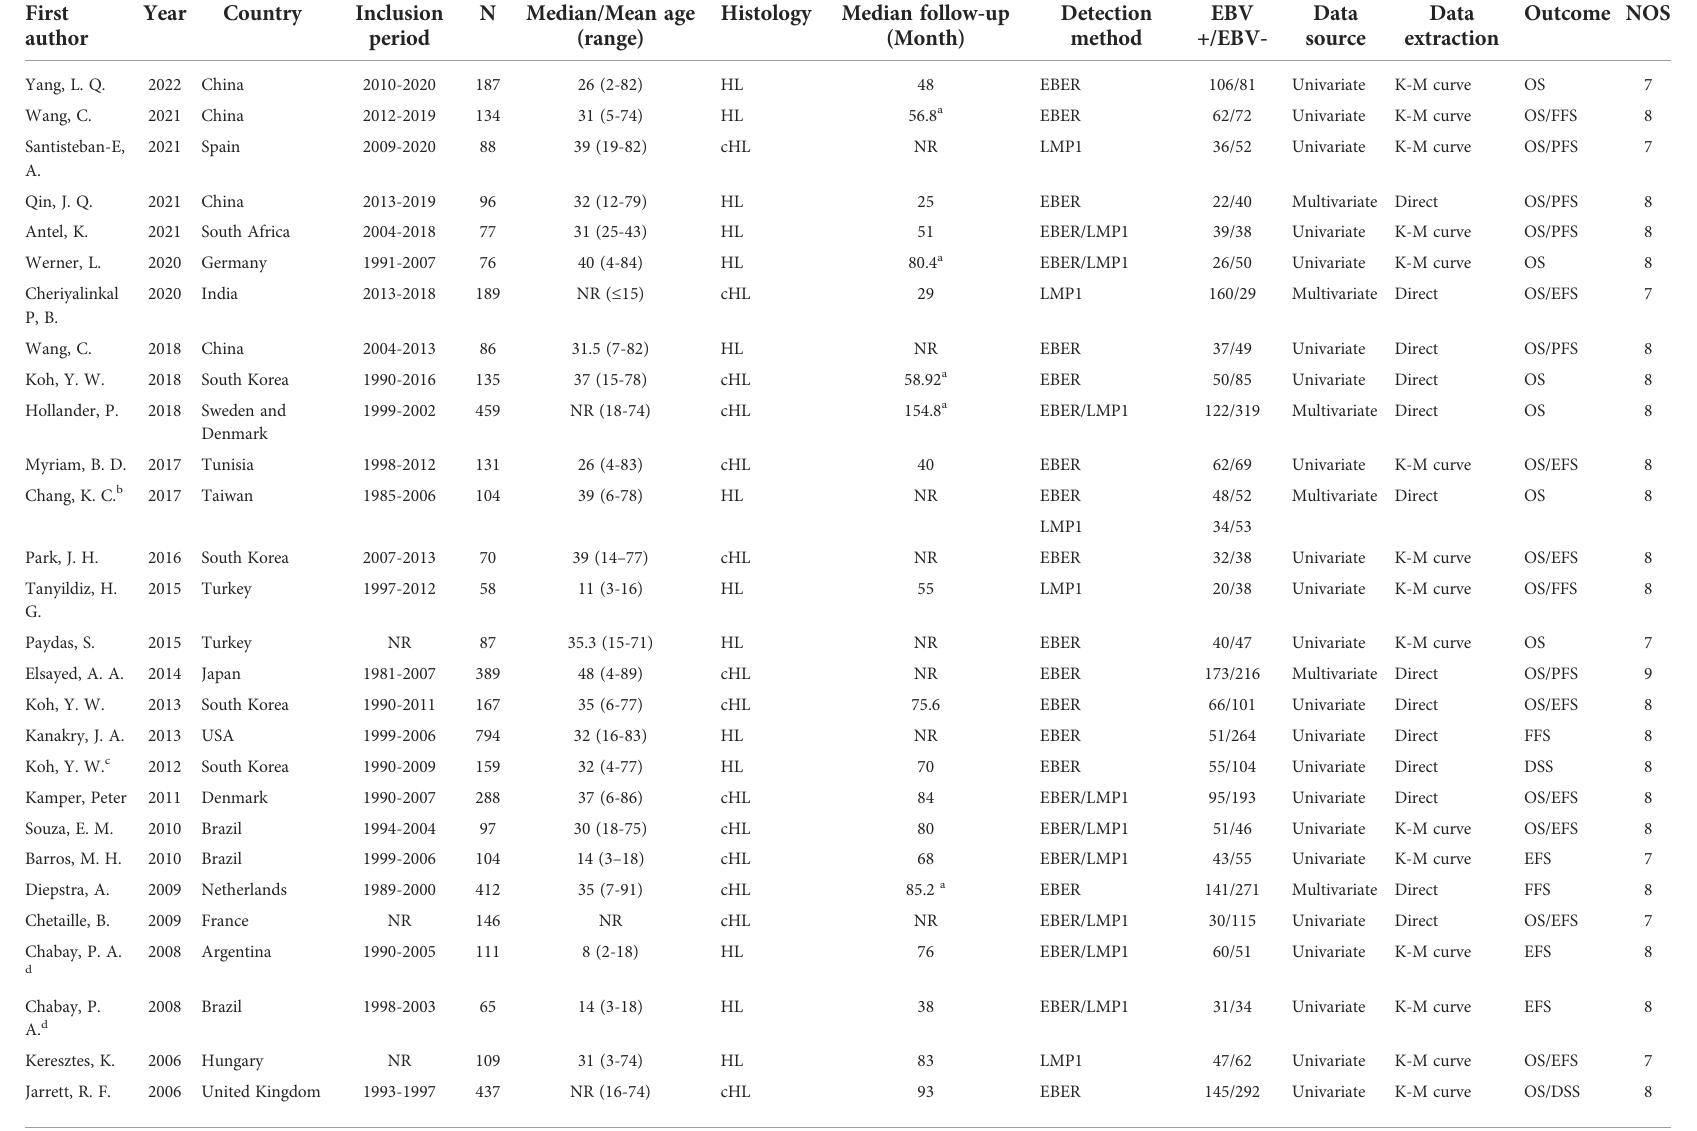
TABLE 1 Main characteristics of the included